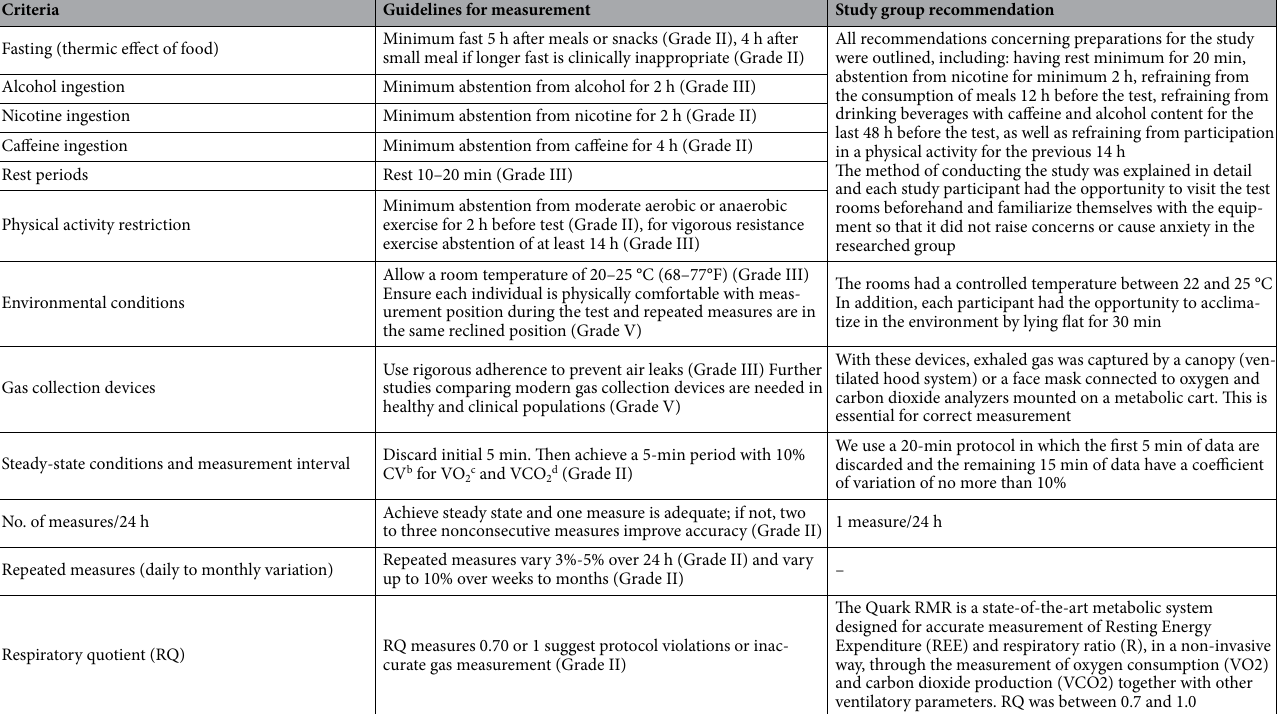
Table 1. Evidence-based guidelines for measurement of resting metabolic rate with IC. a Grade I—strong, consistent evidence; Grade II—somewhat weaker evidence and disagreement among authors may exist; Grade III—limited design quality; Grade IV—professional opinion only, no clinical trials; Grade V—no available studies. b CV—coefficient of variation (standard deviation [mean of individual replicate measures] × 100). c VO